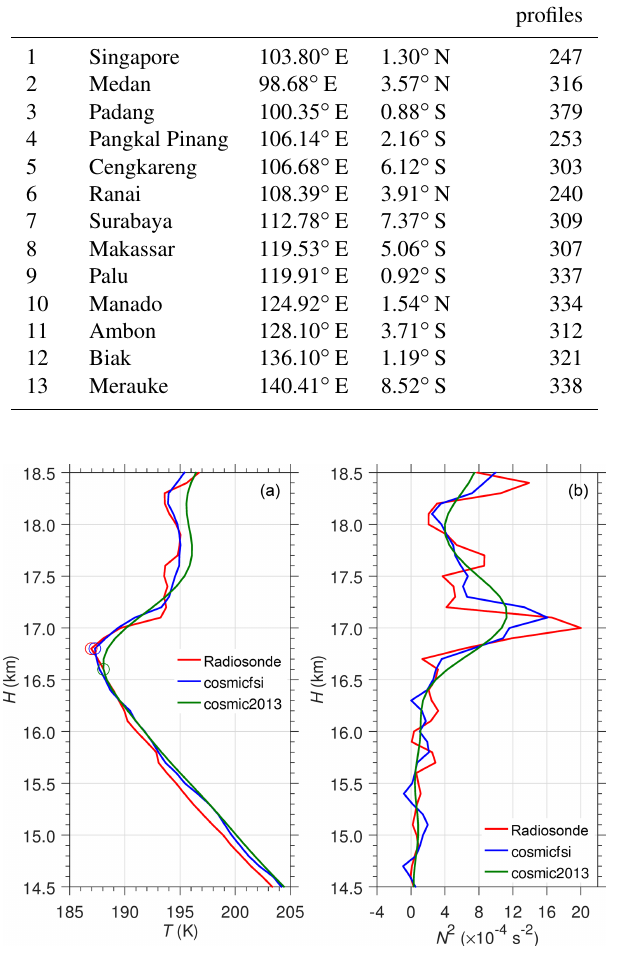
Figure 1. A typical COSMIC GPS-RO profile near the radiosonde balloon launch in Surabaya on 24 November 2011. Circles in panel (a) indicate the CPT.